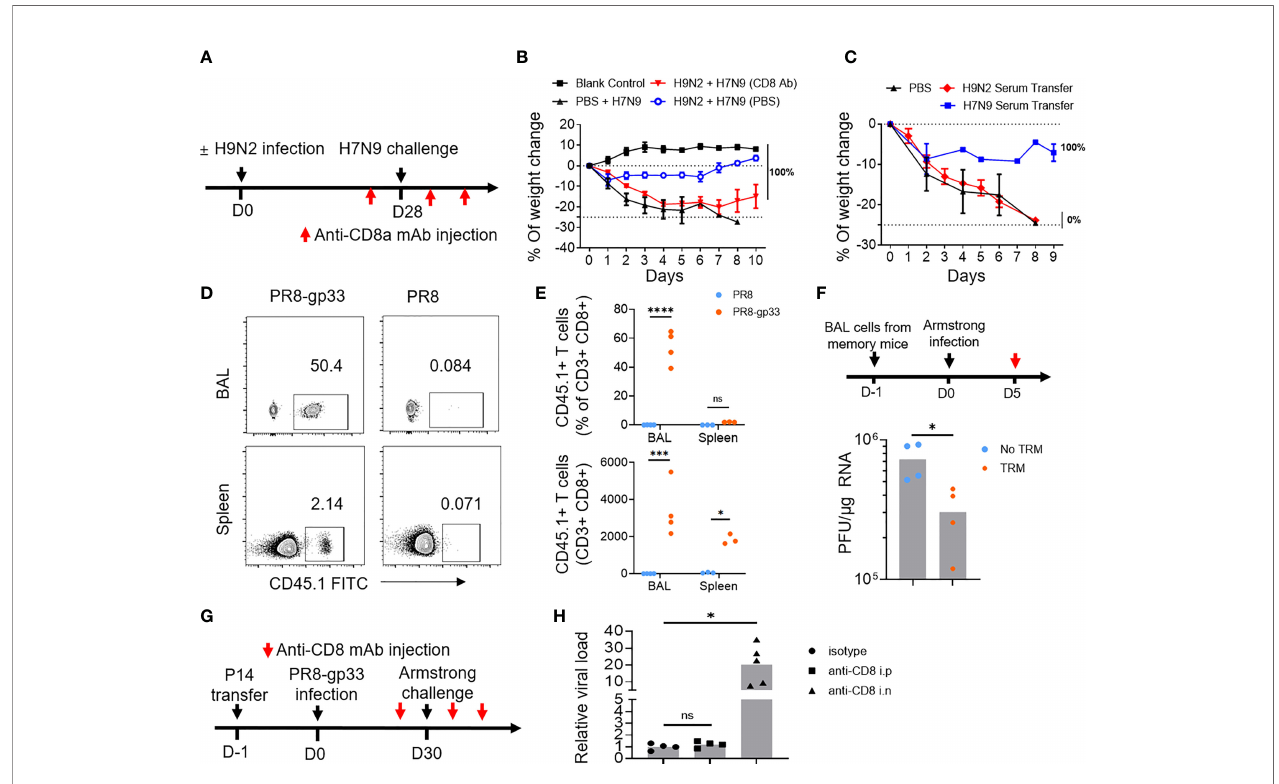
FIGURE 2 | Lung CD8+ T RM cells have high potential to afford cross-protein against virus infection. (A, B) Mice primed with PBS or H9N2 infection were challenged with a lethal dose of H7N9 virus following the schedule described in Figure 1A , except that intraperitoneal injection of anti-CD8a or control antibody was applied at 1 day prior to H7N9 challenge as well as day 1 and day 3 after the challenge (A) . H7N9 infection-induced weight changes were daily monitored (B) . (C) Mice received transfusion of serum from H9N2- or H7N9-infected mice and were subsequently challenged with a lethal dose of H7N9. The survival rate was determined daily after the challenge. (D – F) Mice were seeded with P14 cells by adoptive transfer and infected with PR8-gp33 or PR8 virus. Thirty days later, the abundance of P14 cells in the bronchoalveolar lavage (BAL) and spleen of resulting memory mice were analyzed by fl ow cytometry, with representative fl ow cytometry plots shown in (D) , and pooled absolute and percent (among total CD8+ population) enumeration data shown in (E) . The BAL fl uids were harvested from memory mice ( n = 5) and i.n. transferred into naïve mice, which were then challenged with i.n. infection of LCMV Armstrong and 5 days later subjected to lung viral load determination (F) . (G, H) Memory mice were developed the same as in (D, E) , followed by the LCMV Armstrong challenge, along with anti-CD8 or isotype control antibody being injected either intranasally (i.n.) or intraperitoneally (i.p.) both at 1 day before and at 1 day and 3 days after the challenge (G) . (H) Lung viral loads were determined at day 5 after the LCMV Armstrong challenge. Data are representative of two or three independent experiments with n = 3 (B, C) . * p < 0.05, *** p < 0.001, **** p < 0.0001; ns, not signi fi cant; two-way ANOVA (E) ; Mann – Whitney U test (F , H)